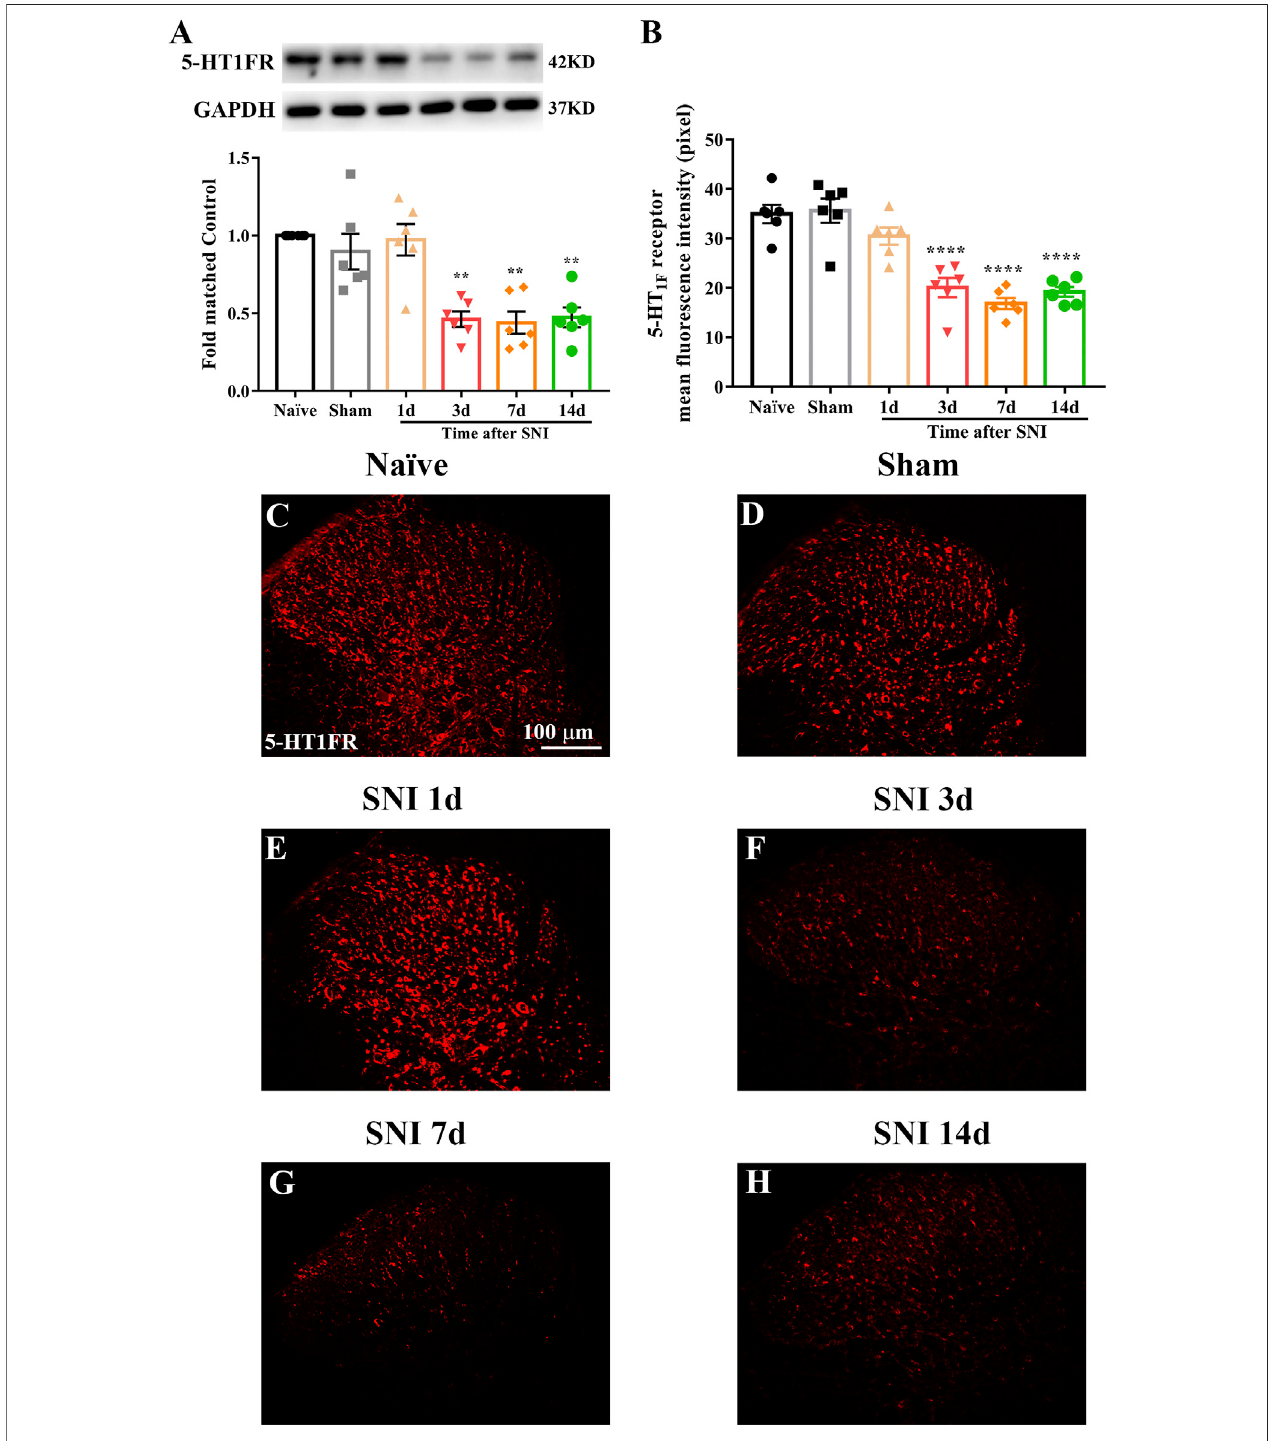
FIGURE3| Expressionof5-HT 1F receptorinthespinalcordofshamandneuropathicpainrats. (A) Theproteinlevelof5-HT 1F receptorwassigni fi cantlydecreased in SNI rats, beginning at day 3 after surgery and remain at low level until day 14 (** p < 0.01 compared with sham group, n = 6 in each group). (B) Histogram showing the meanintensityof5-HT1Freceptorimmuno fl uorescentactivitywassigni fi cantlydecreasedinSNIrats,beginningatday3aftersurgeryandremainatlowleveluntilday14 (**** p < 0.0001 compared with sham group, n = 6 in each group). (C – H) Representative photomicrographs showed that neuropathic pain induced the downregulation of 5-HT 1F receptor in the spinal